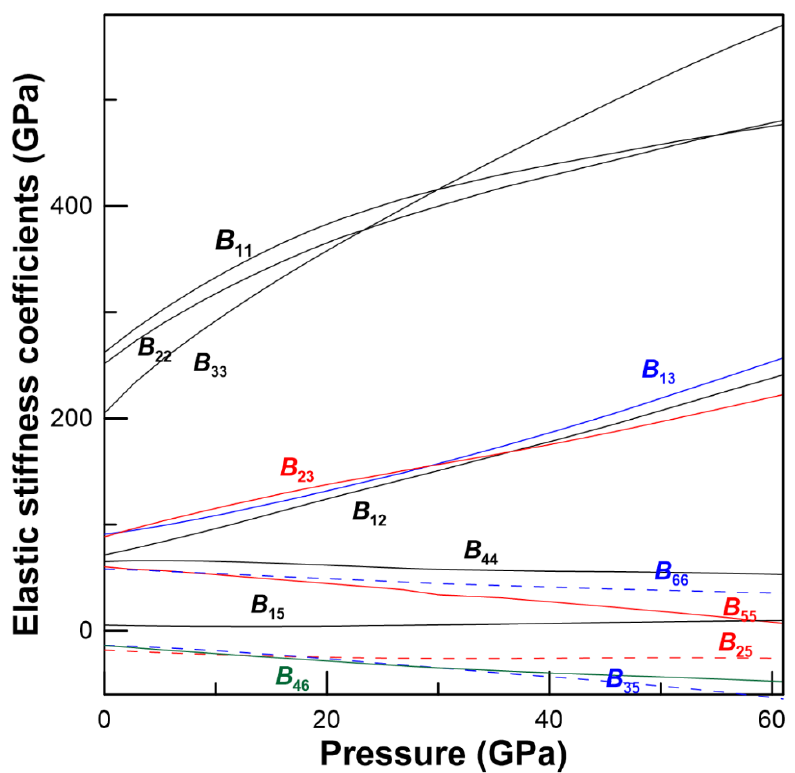
Figure 4. (Color online) Pressure evolution of the elastic stiffness coefficients, B ij . Figure 4. ( Color online ) Pressure evolution of the elastic stiffness coefficients, B ij